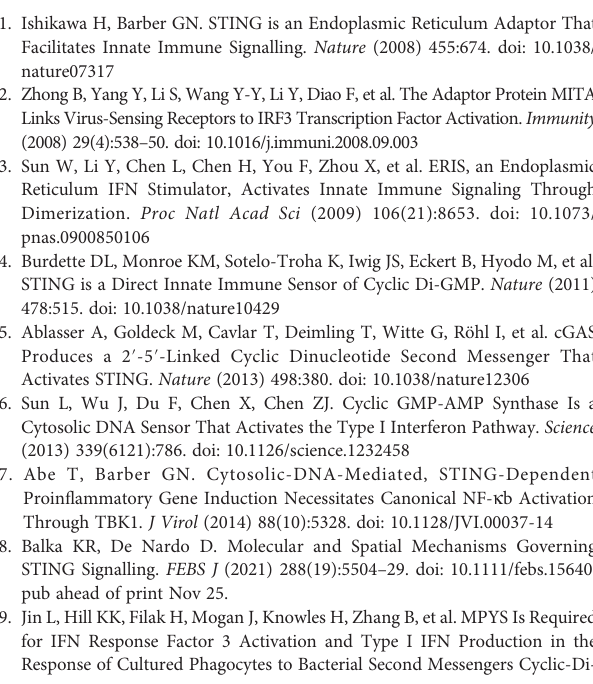
independent donors were stimulated with 5 nmol 2 ’ 3 ’ cGAMP or its linearized control ligand(linGAMP Ctrl) complexed withlyovec inthe presenceorabsence of 5 m g/mL neutralising anti-IFN- l 1 antibody (anti-IL-29, MAB15981, R&D Systems) or antibody controlfor 18h. (C) pDC numberswereenumeratedusing fl owcytometry. Bar graphs show mean ± SEM and each dot represents individual human blood donors (n=4). (D) CD69 expression on pDC were determined using fl ow